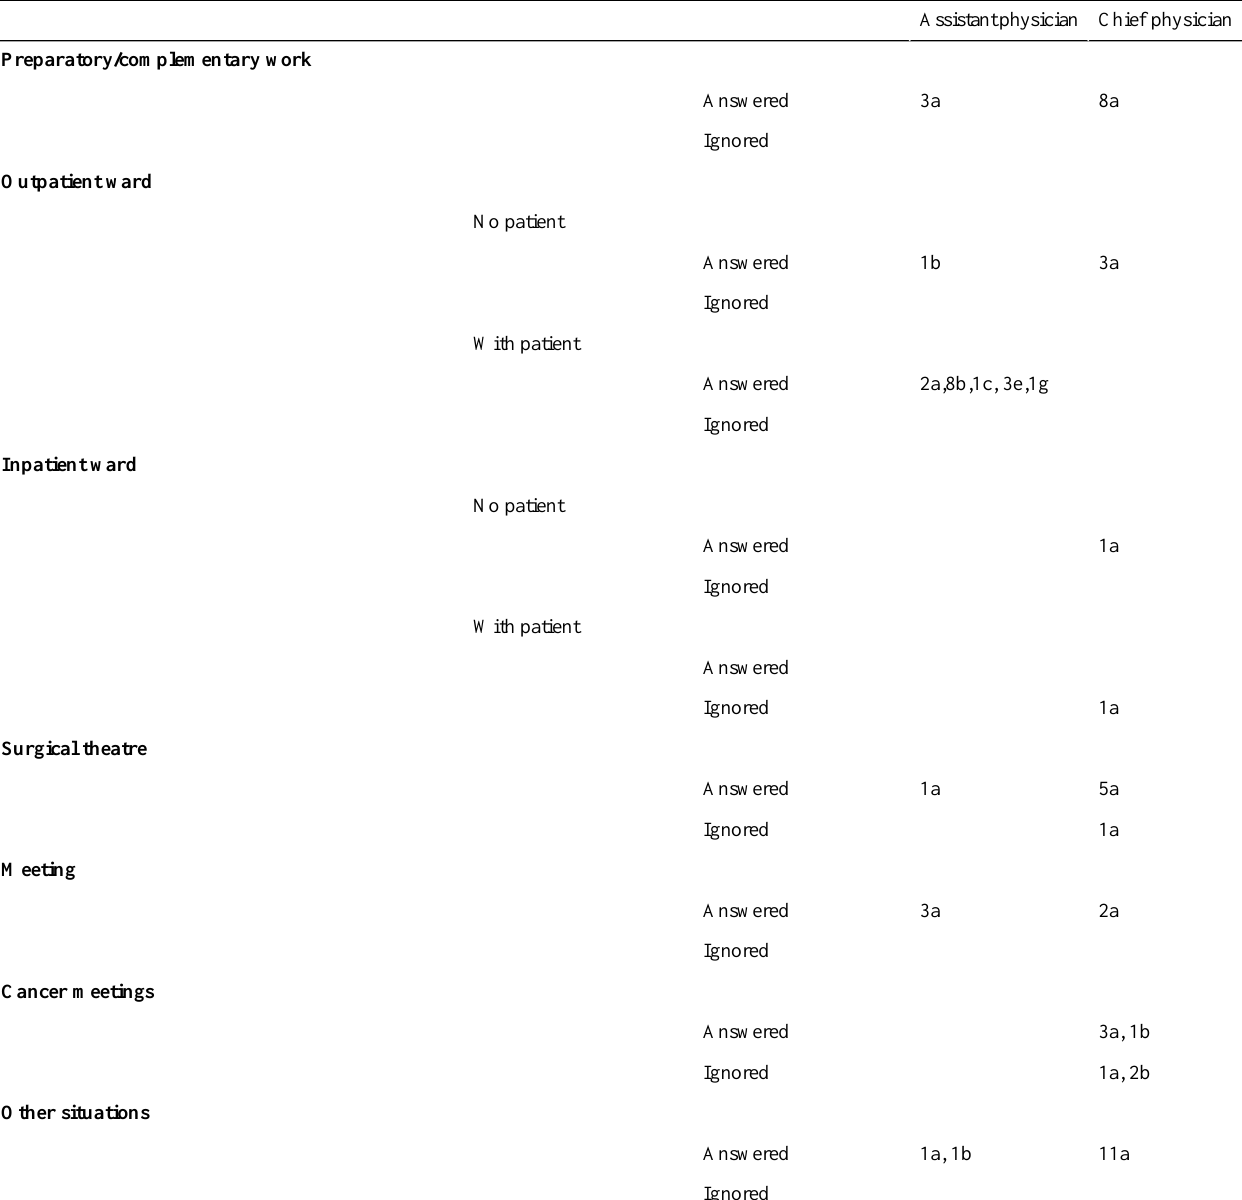
Table 1. Overview of total amount of interruptions from mobile devices at ENT during observation time (only interruptions from the followed physicians’ devices, except for g , which was a nurses’phone brought to the physician).